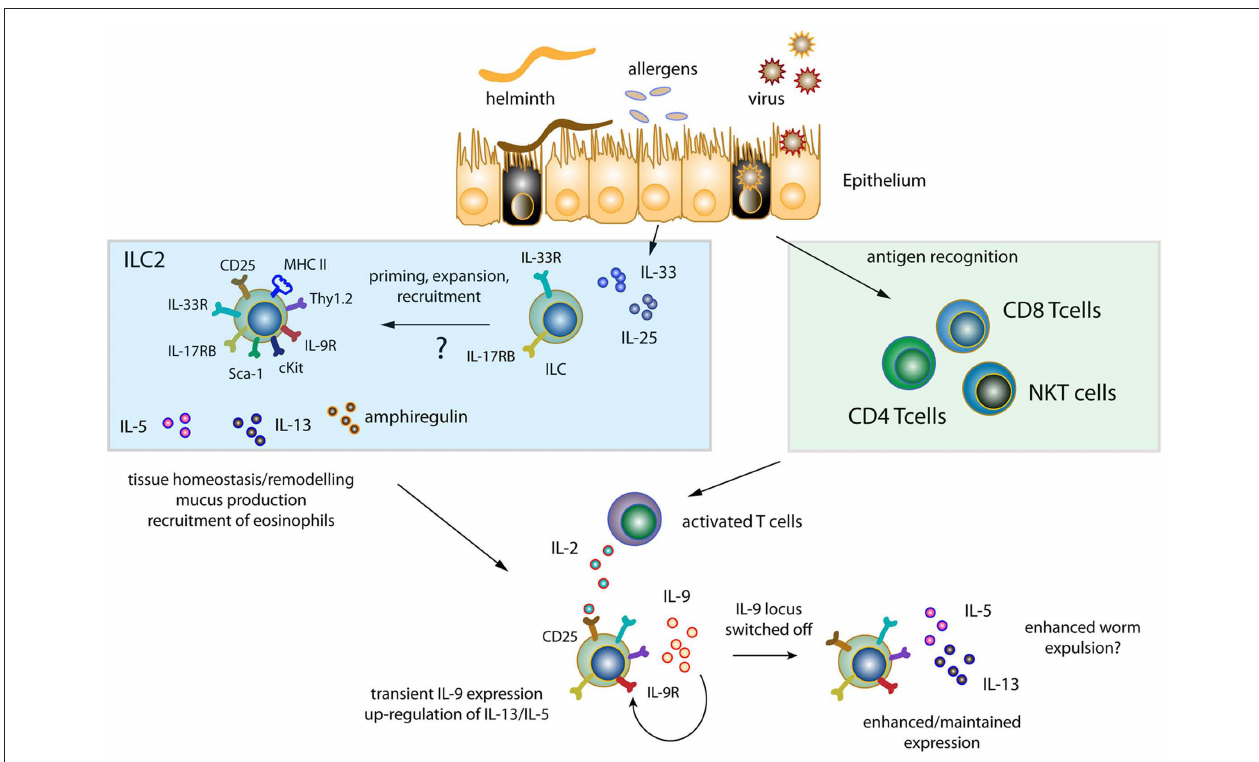
activation status. Soluble factors released by ILC promote recruitment of eosinophils and features of airway hyperreactivity such as mucus production and tissue remodeling/repair. In addition, exposure to helminthes, viruses, and allergens results in antigen recognition and T cell activation (CD4, CD8, and NKT cells). T cell activation in turn leads to the release of IL-2, which induces transient IL-9 expression from ILC further enhancing/maintaining IL-5 and IL-13